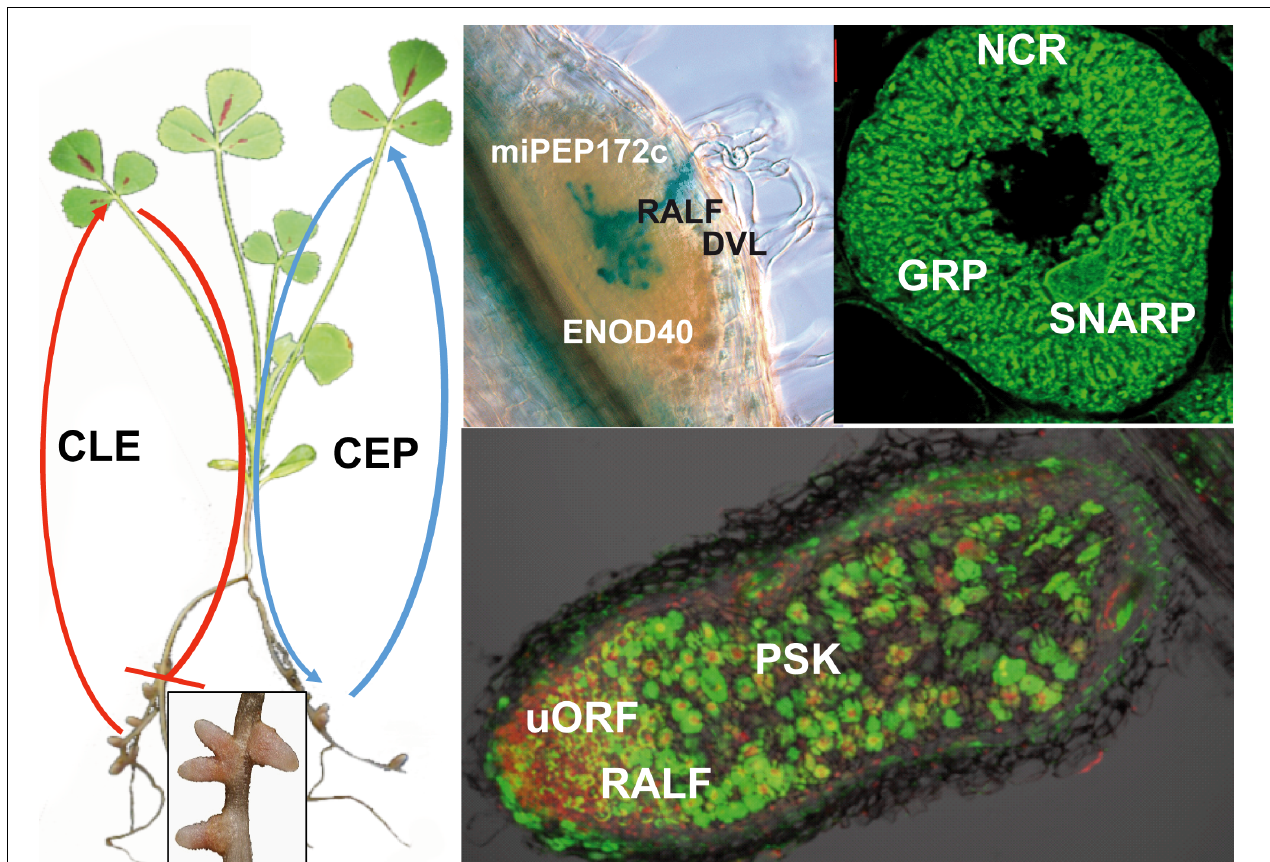
FIGURE 1 | Peptides contributing to nodule formation. The left part of the figure presents a nodulated M. truncatula plant. The inset shows an enlarged image of nodules. The upper pictures show a section of a nodule primordium showing a network of infection threads stained in blue (Left) , and a symbiotic nodule cell densely packed with differentiated bacteroids (Right) . The lower image is a section of a mature nodule showing the rhizobia in green. The red staining shows plant cell nuclei, highlighting primarily the nodule meristem. Peptides involved in nodulation are indicated at their presumed site of action. CLE peptides are produced in response to already initiated nodules or by high nitrate. They are systemic signals received in the shoot by the HAR1/SUNN/NARK receptor-like kinases, which in return produce a shoot-derived signal that inhibits further nodulation in the roots. CEP peptides on the other hand are produced in the roots and their production is enhanced by low nitrogen. The peptides are perceived by the CRA2 receptor-like kinase and stimulate nodulation through a systemic mechanism. The RALF and DLV peptides negatively affect the infection process in early stages of nodule development. During later stages, RALF has a negative, while PSK has positive effect on the process. ENOD40 and miPEP172c affect nodule primordium formation. uORFp1 participates in the control of the meristem maintenance. NCR peptides and potentially also the GRP and SNARP peptides control bacteroid differentiation and functioning.